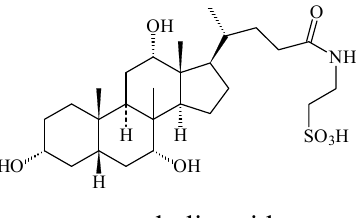
Figure 11. Structures of cysteic acid and taurocholic